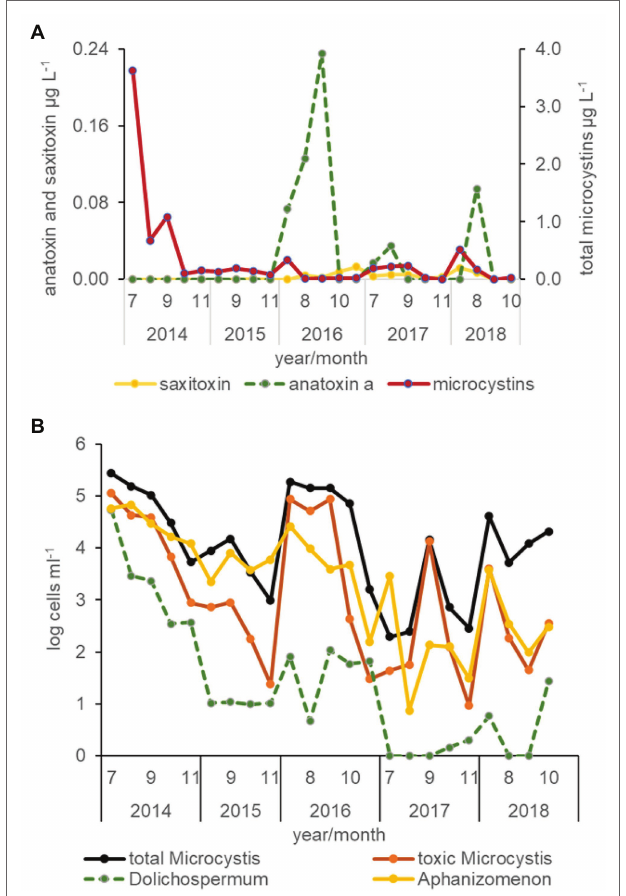
FIGURE 6 | Average concentration of cyanotoxins determined by protein phosphate inhibition assay (PPIA) analysis (A) and the abundance of total Microcystis , toxic Microcystis , Dolichospermum , and Aphanizomenon cells for all stations by month and year between 2014 and 2018 determined from qPCR analysis (B) .